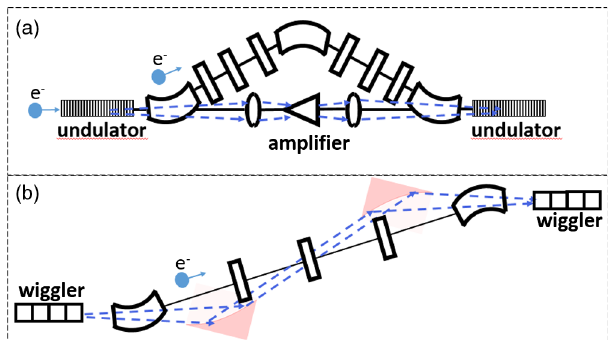
FIG. 2. (a) A conventional concept of the optical stochastic cooling system. The light radiated in the upstream undulator is focused to the optical amplifier and refocused to the downstream undulator. The electron beam follows the bypass comprised of the bending magnets and quadrupoles. (b) The new concept.